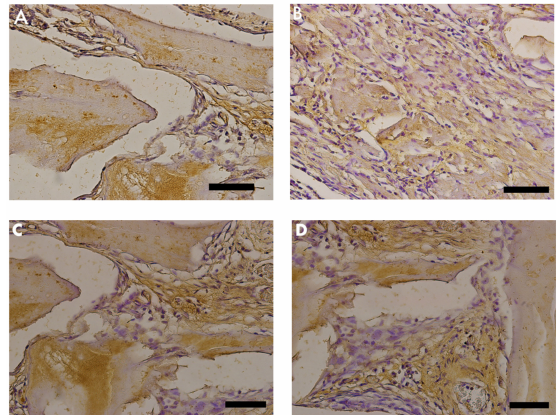
Figure 7. Photomicrographs of tumor necrosis factor (TNF)- α stained slides. Brown color indicates osteoclast activity. ( A,C ) Group 1 (bone xenograft), ( B,D ) Group 2 (nano-hydroxyapatite / beta-tricalcium phosphate composite). Scale bar = 100 µ m, 400x magnification.